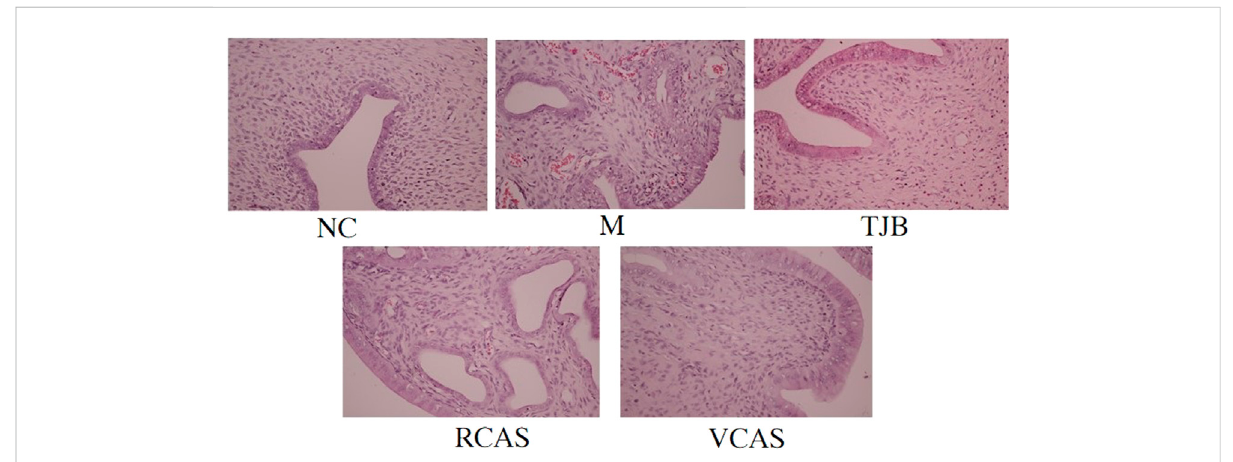
FIGURE 1 Histological morphology examinations of the uterus (× 400). NC: normal control group, M: model group, TJB: positive drug group, RCAS: raw Curcuma aromatica Salisb. [Zingiberaceae], VCAS: vinegar processed Curcuma aromatica Salisb.